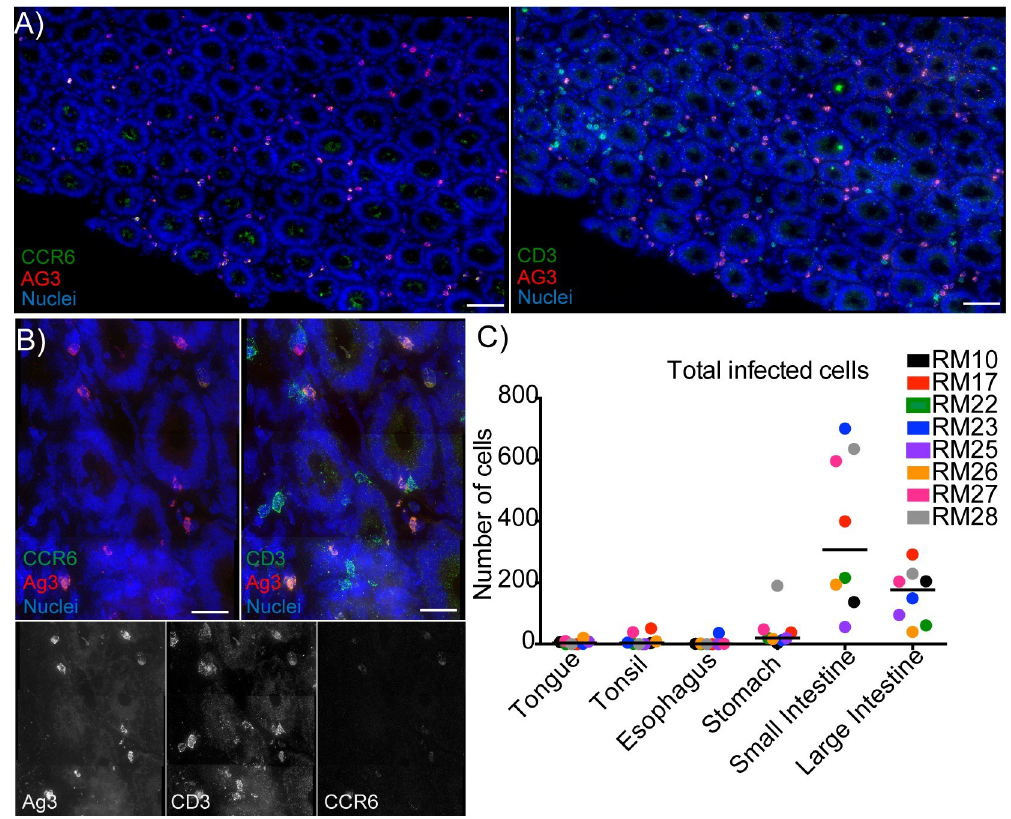
Fig 3. The majority of SHIV-1157ipd3N4 infected cells are found in the small intestine 96 hours after oral challenge. Fluorescent microscopy and quantification of SHIV-1157ipd3N4 infected cells from eight animals that were sacrificed at 96 hours after dual viral oral challenge. Tissues were dissected, analyzed by IVIS, frozen, and tissue blocks with high luciferase activity were cryosectioned. Slides were stained for CD3, CCR6, AG3, and Hoechst. Representative fluorescent microscopy images. A-B) Cryosections of the small intestine showing SHIV-1157ipd3N4 infected cells A) 40X panels, scale bars 60 microns B) 100x panels, scale bars 20 microns C) Quantification of total number of SHIV-1157ipd3N4 infected cells by tissue type. Each dot represents the total number of cells found in five 40x panels in one individual